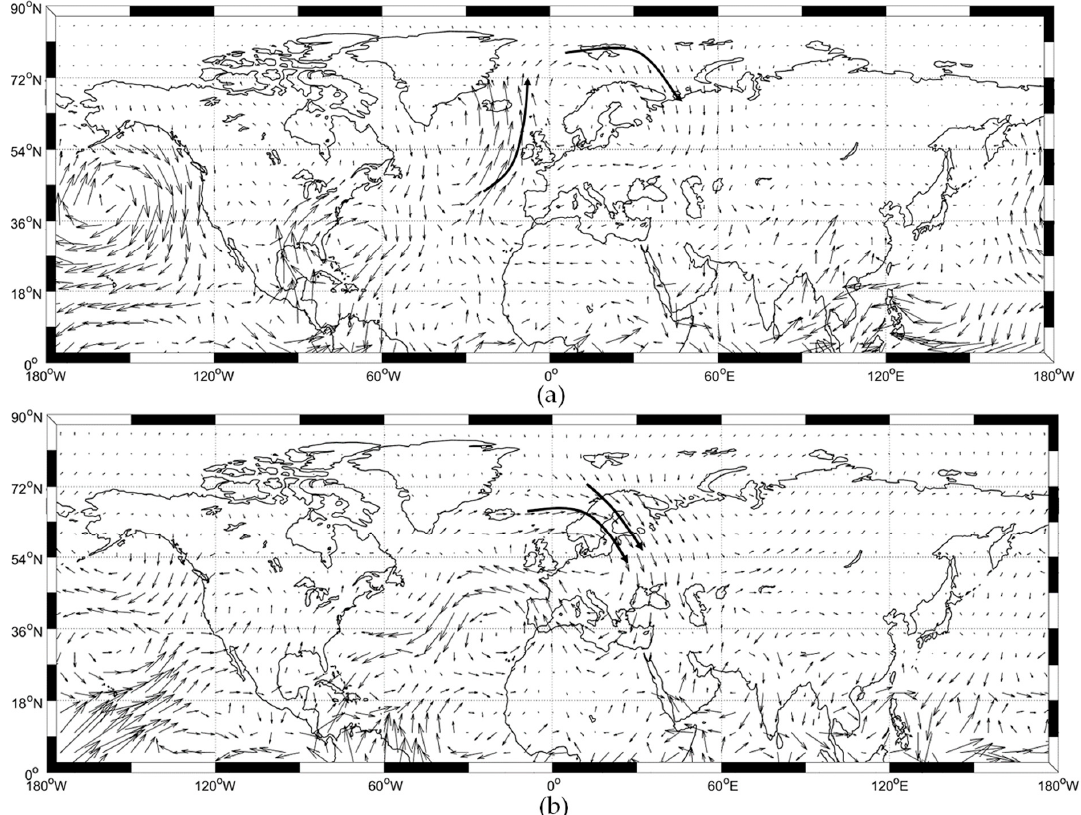
Figure 6. ( a ) The winter water vapor transport anomaly in low sea ice index years (2007, 2008, 2012, and 2016); ( b ) the water vapor transport anomaly in high sea ice index years (1988, 1992, 1994, 1996, 1997, 1998, and 2001).